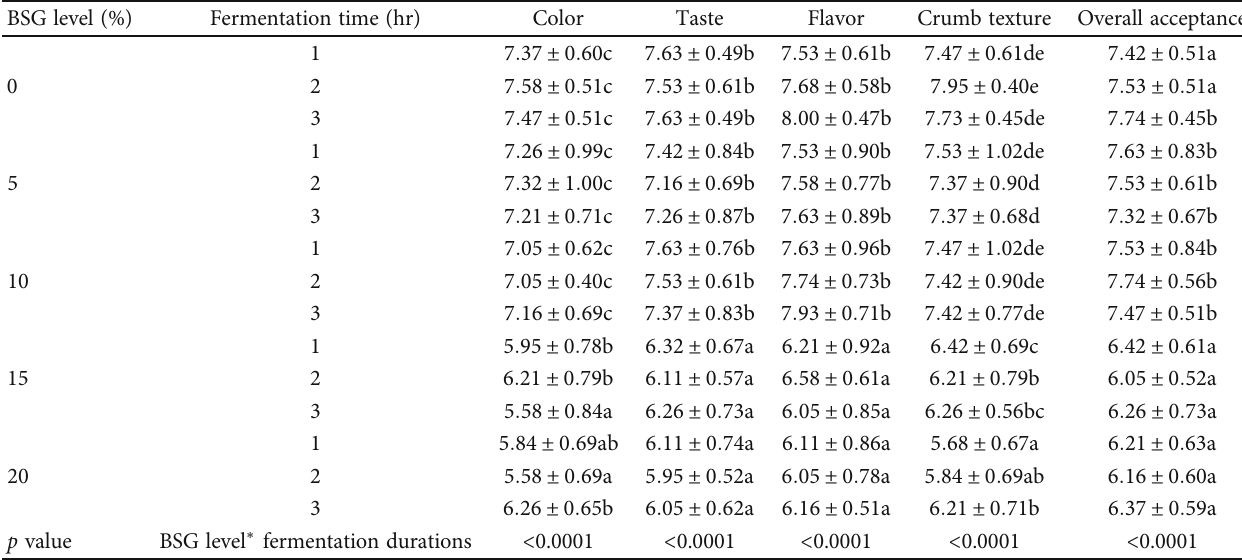
Table 6: Sensory evaluation results of bread prepared by addition of BSG on 9-point hedonic scale. BSG level